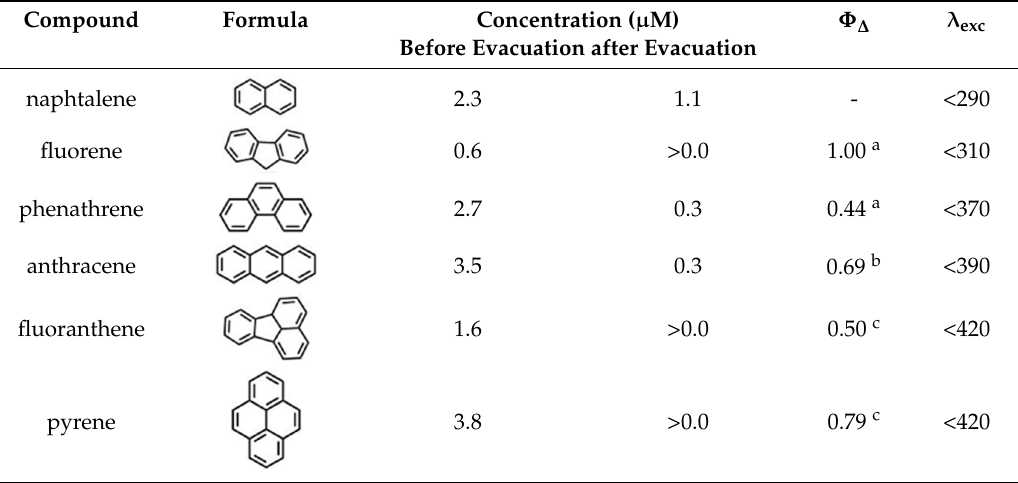
Table 1. Concentrations of aromatic species found in SC-500 extract and literature values of quantum yields of singlet oxygen formation ( Φ ∆ ).